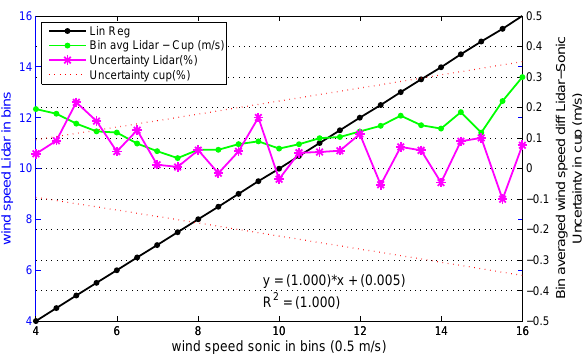
Figure 3. Verification test for wind speed deviation between Lidar and cup anemometer at 80m height.Verification test comprising of the binwise deviations of the wind speed difference between cup and Lidar, uncertainty of cup and statistical uncertainty of the test.